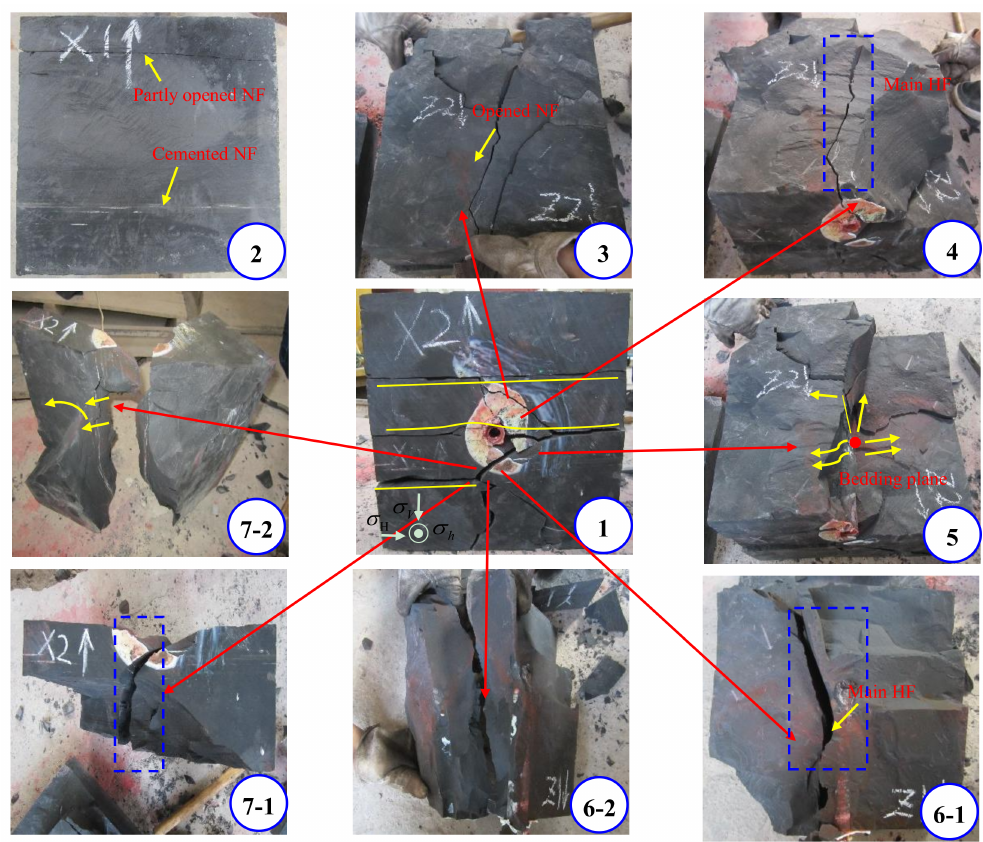
Figure 20. Photographs of specimen Y-7-3 after conducting